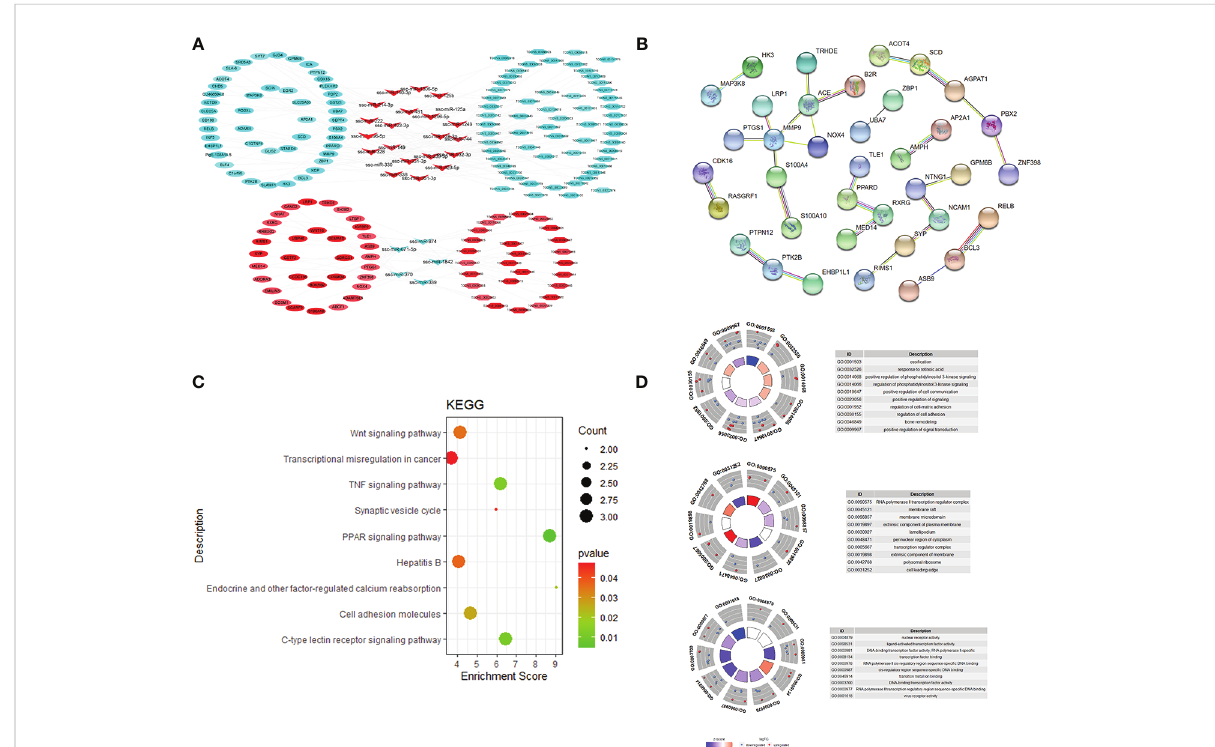
FIGURE 4 ceRNA regulatory network and target gene biology analysis of lncRNA, miRNA and mRNA regulatory network (A) ; protein-protein interaction network (B) ; KEGG pathway enrichment analysis results (C) ; GO enrichment results (D)